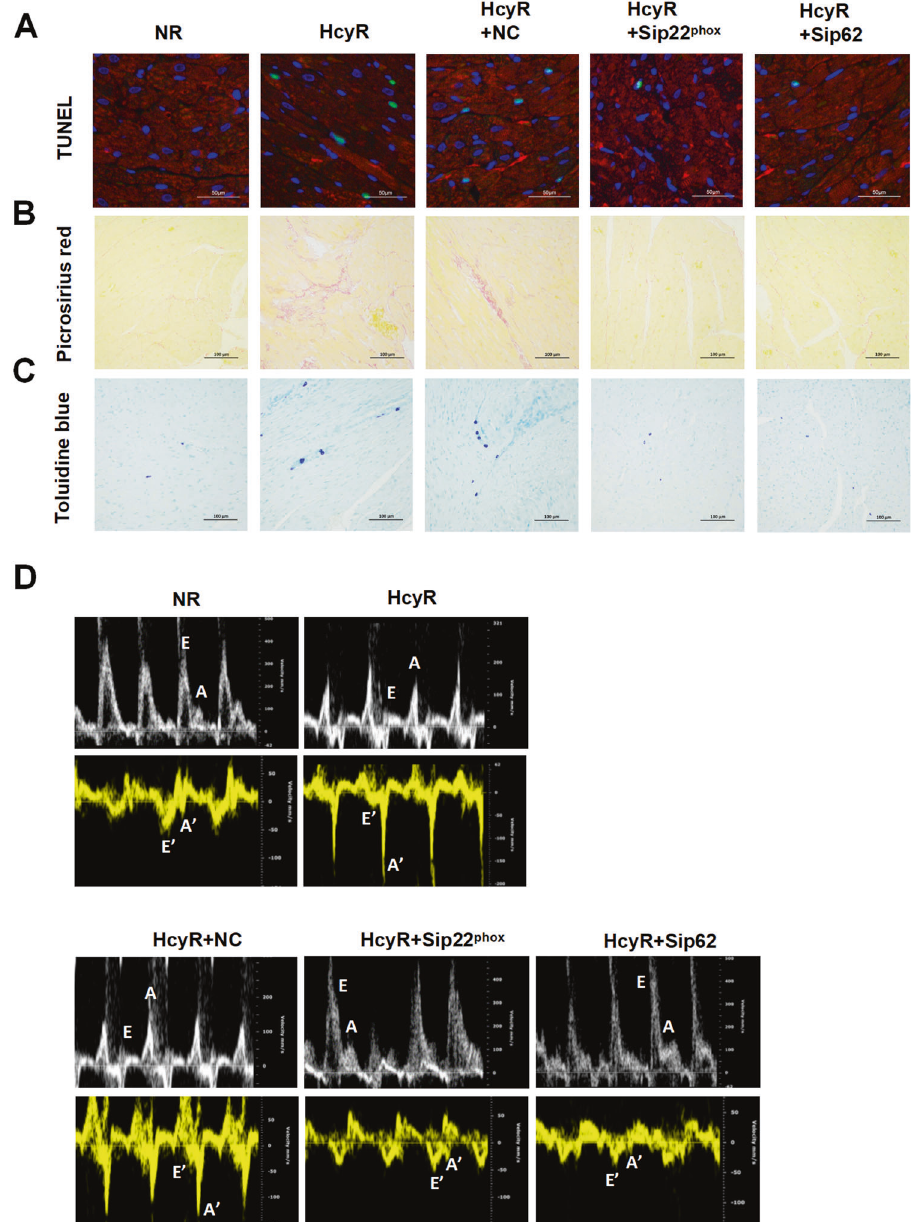
Fig. 6 Effect of sip22 phox or sip62 administration on cardiac morphology and function in HcyR. The representative myocardial sections show cardiomyocyte cross-sectional area of TUNEL positivity ( A ), myocardial fi brosis ( B ), and mast cell in fi ltration ( C ). ( D ) Representative transmitral fl ow velocity and Doppler tissue imaging (DTI) mitral annulus velocity patterns. E peak velocity of early mitral in fl ow, A peak velocity of late mitral in fl ow, E ′ early diastolic velocity of the mitral annulus, A ′ late diastolic mitral annulus velocity. n = 7 rats/group. NR: HcyR + NC, HcyR + Sip22 phox , HcyR + Sip62 (see Fig.